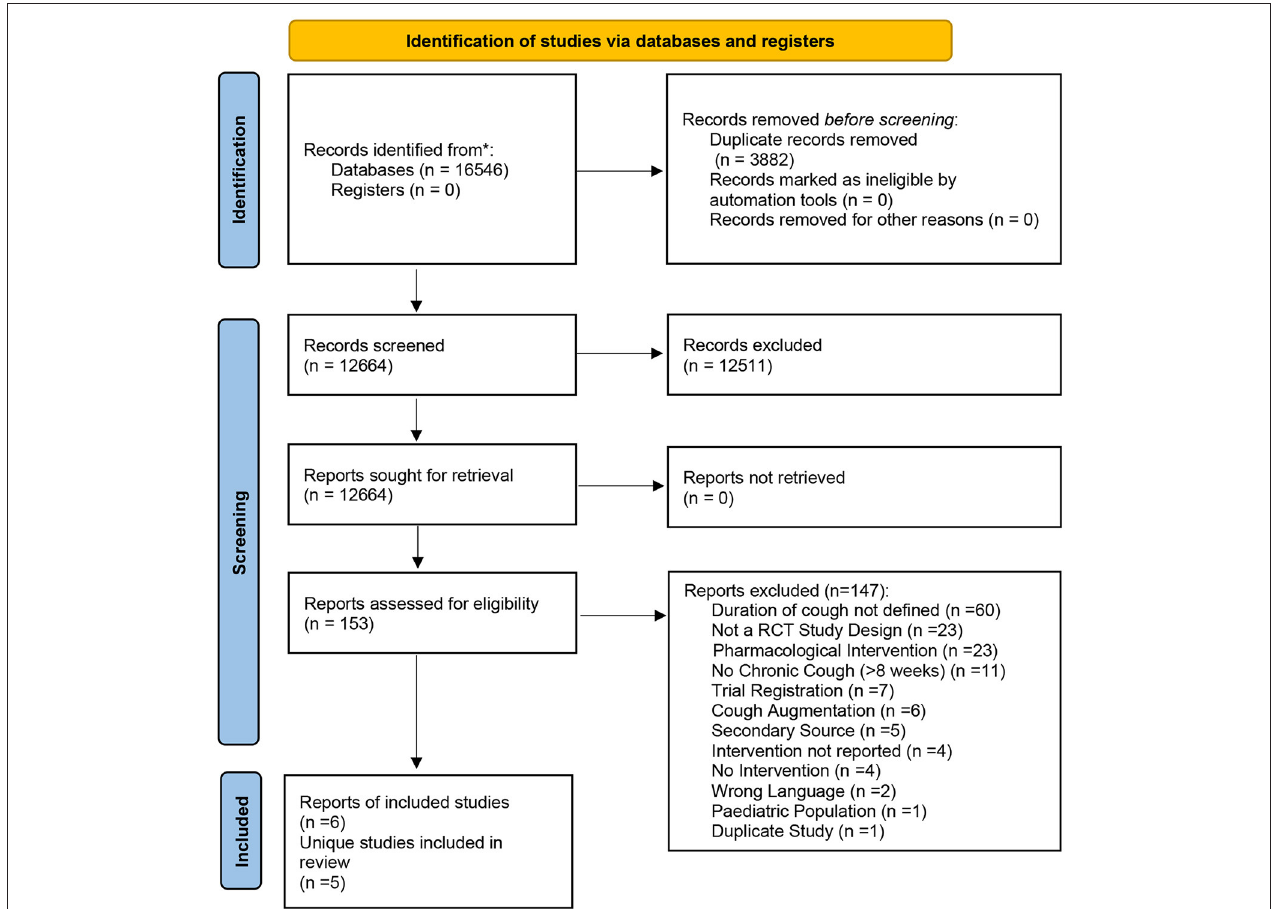
FIGURE 1 | Flowchart of records and studies included in the systematic